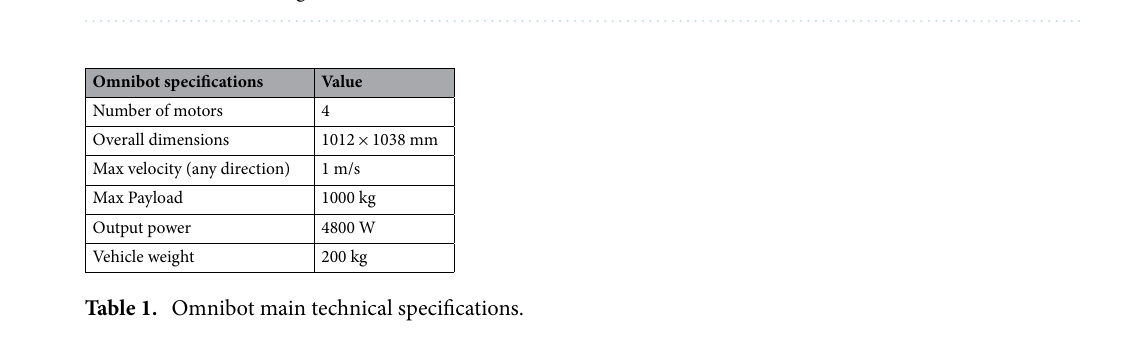
Figure 1. The omnidirectional vehicle used for this research study: ( A ) top view of the real robot, ( B ) isometric view of the 3D rendering.